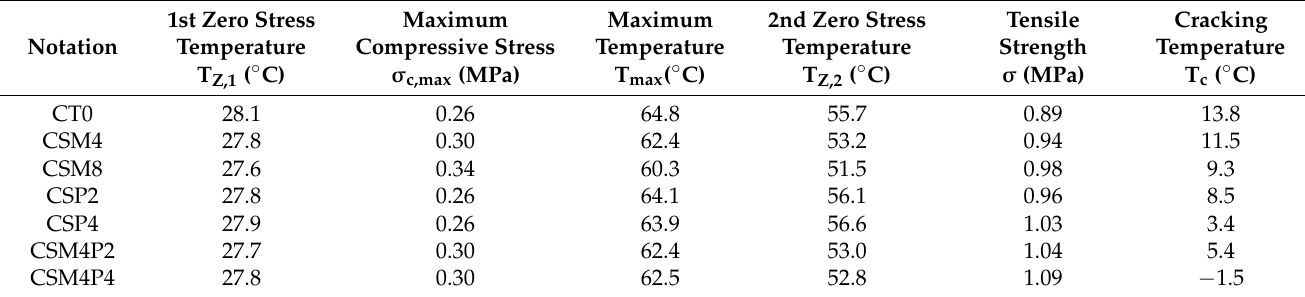
Table 6. The key temperature stress parametersof hydraulic concretes addedwith MgO and/or